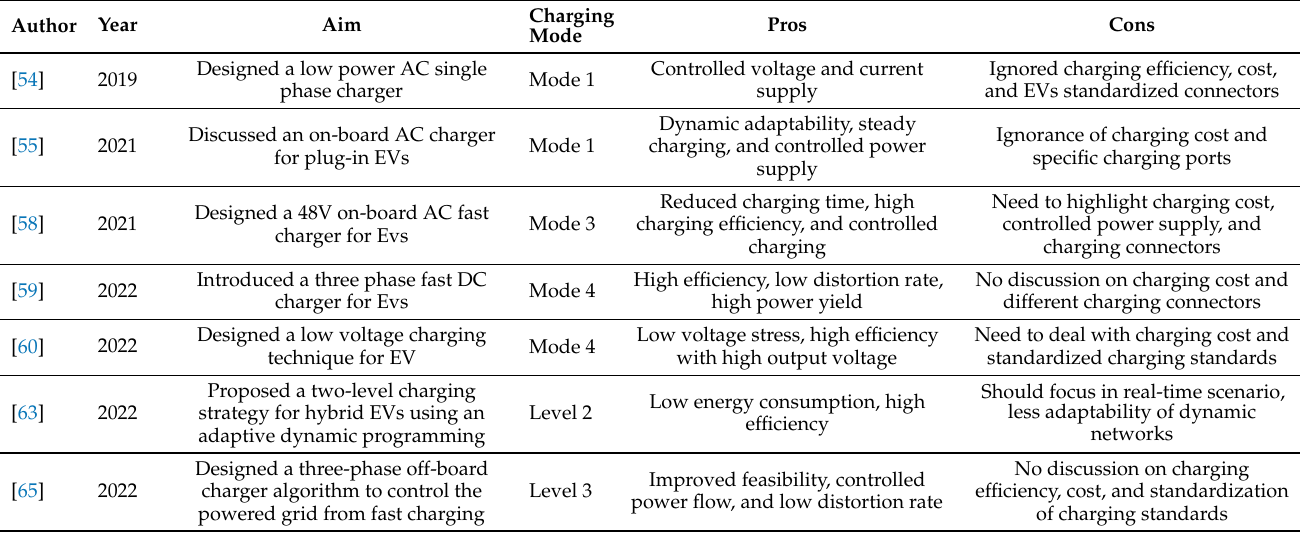
Table 2. Comparative analysis of various EV charging